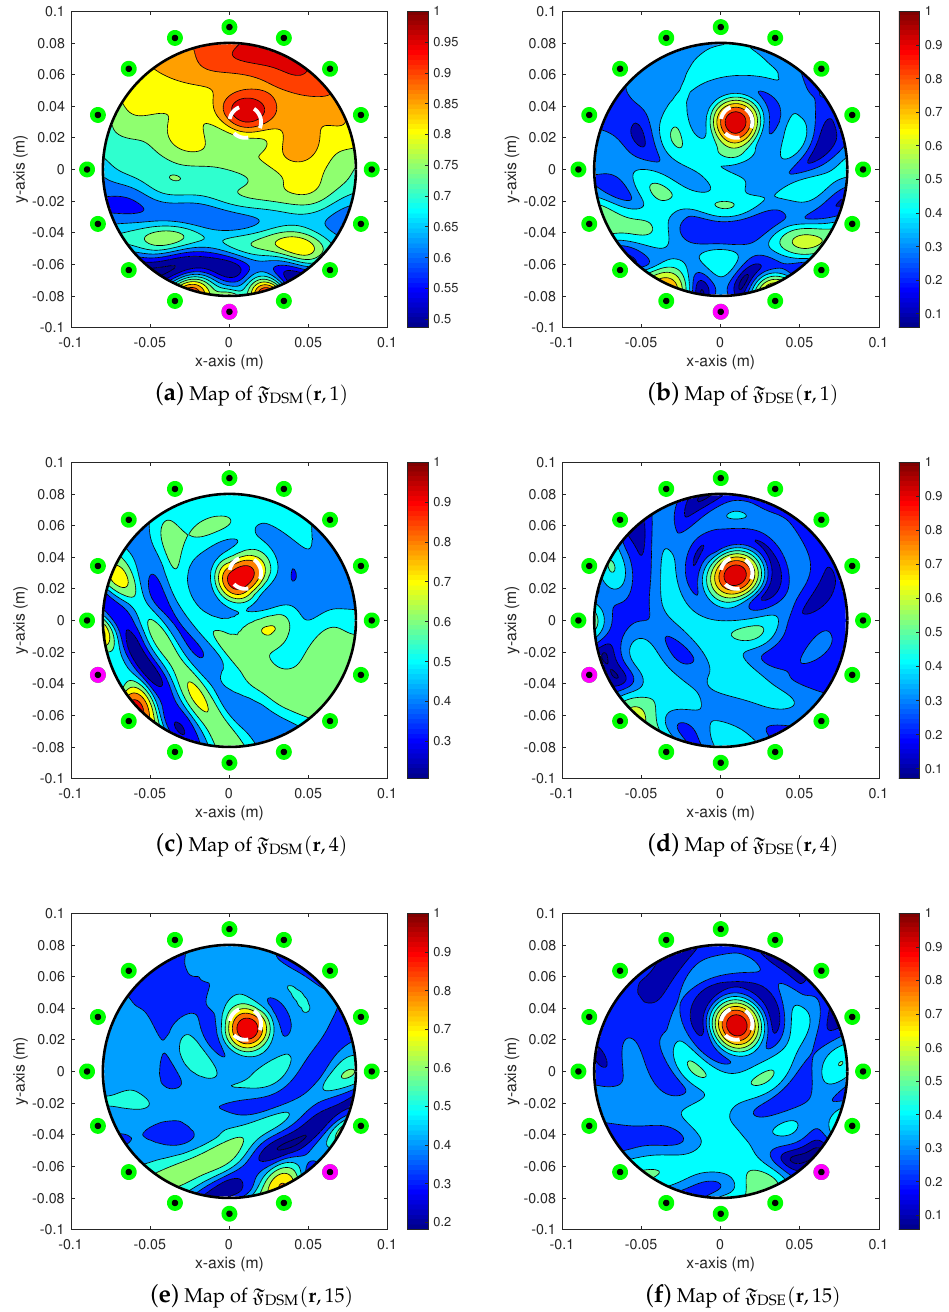
Figure 5. Multi-frequency imaging of F DSM ( r , m ) and F DSE ( r , m ) . White-colored dashed line de- scribes the ∂ D